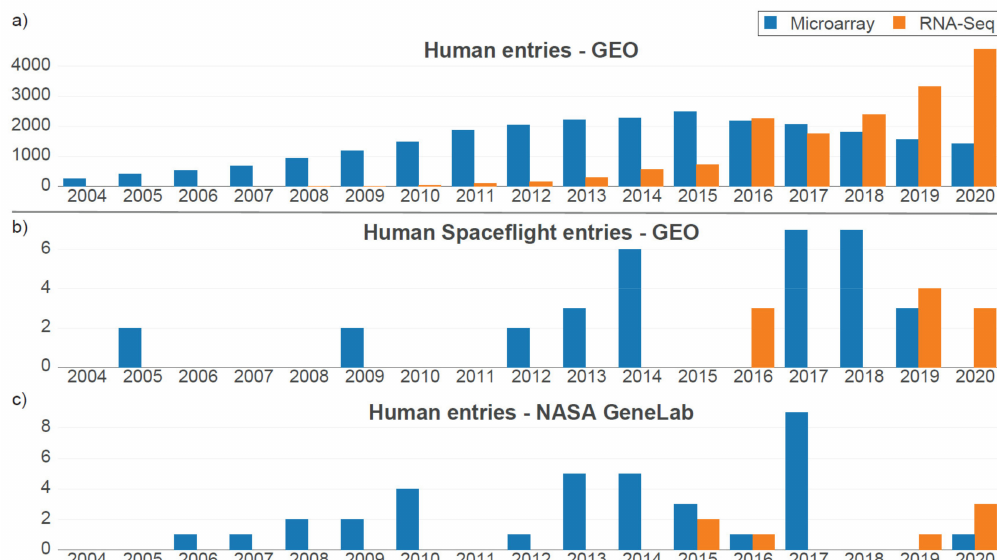
Figure 1. Deposition of RNA-Seq and transcriptomics microarray data sets over time. ( a ) Human transcriptomics data sets deposited in the Gene Expression Omnibus database per year. For most journals, data sets must be made available upon publication. Therefore, deposited data sets directly represent which technologies were used in publications in each year. A general shift towards RNA-Seq appeared in the year 2016. ( b ) Subset of spaceflight-related human transcriptomics data sets deposited in the Gene Expression Omnibus database. The much smaller subset displays the higher popularity of microarray technology compared to the overall set, with a clear trend towards RNA-Seq only in 2020. ( c ) All human entries in the spaceflight/space biology-specific NASA GeneLab database. There is a high correspondence to human spaceflight entries in the GEO